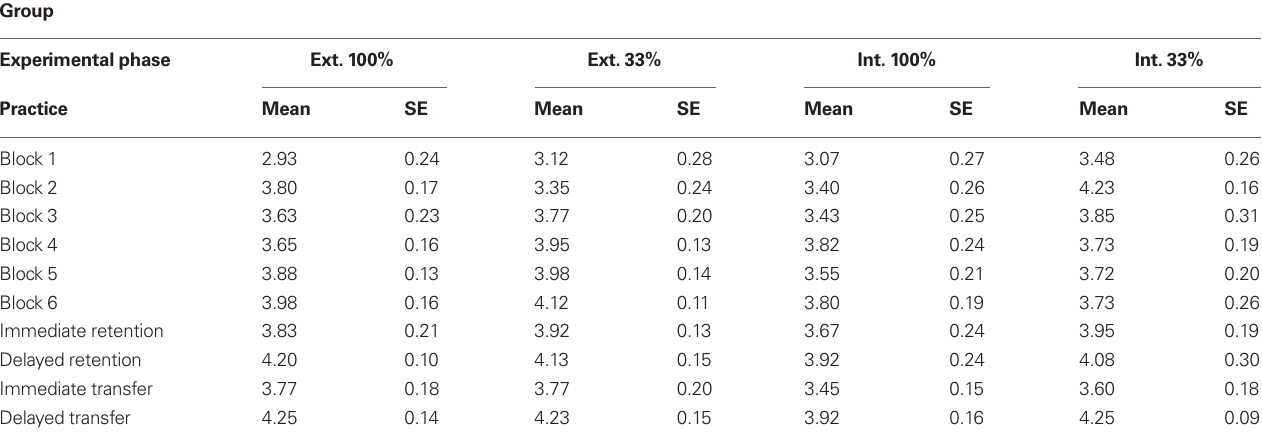
Table 2 | Accuracy scores of the groups receiving external-focus or internal-focus feedback on 100% or 33% of the practice trials, respectively, during practice, immediate and delayed retention, and immediate and delayed